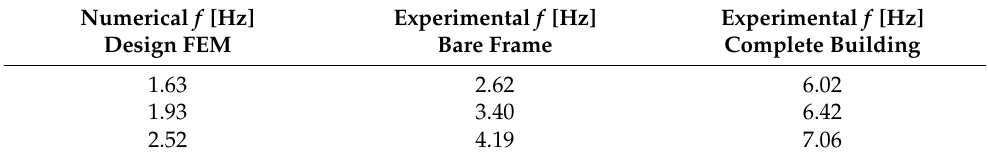
Figure 11. Comparison between experimental and numerical modal parameters after the updating — Part 2/2. Table 7. Comparison between frequencies obtained numerically (design FEM) and